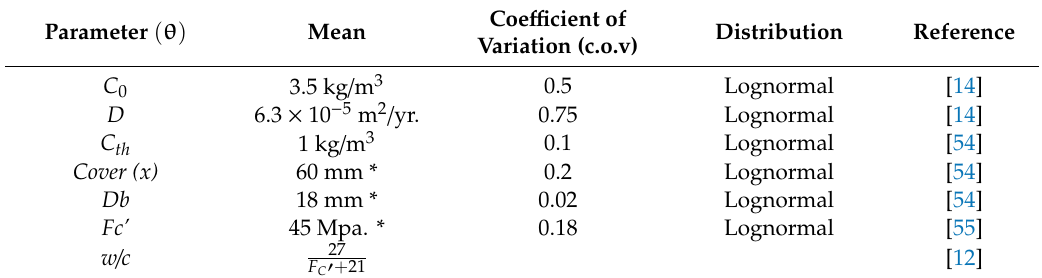
Table 2. Random variables used in Monte Carlo Simulation of concrete deck